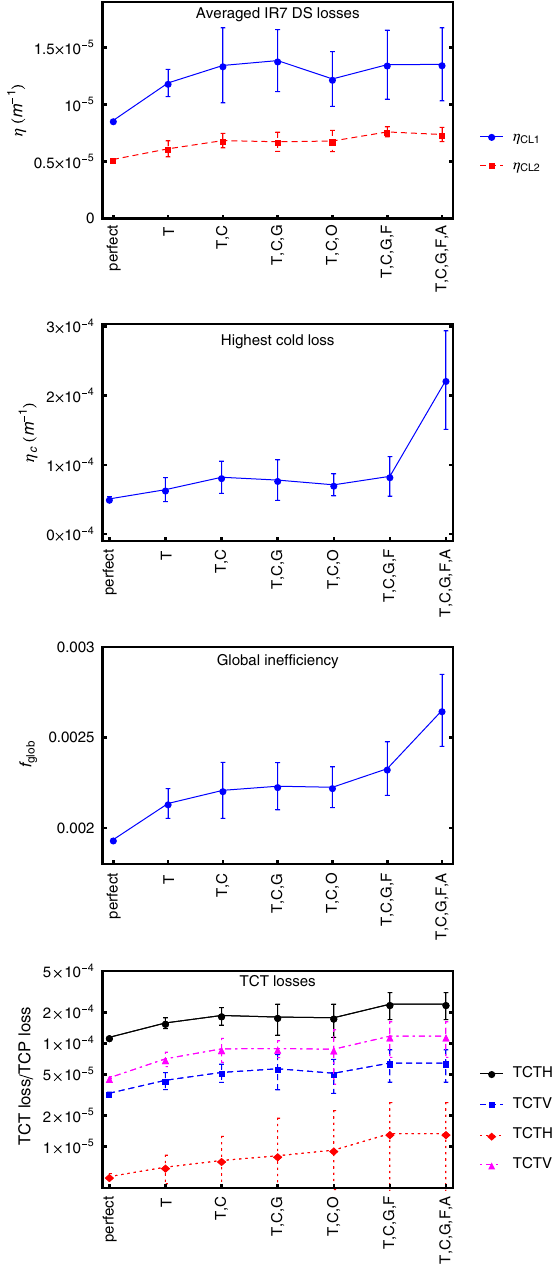
FIG. 12. The influence, as simulated with SixTrack, of different machine imperfections (T designates tilt error; C designates center error; G designates gap error; O designates optics errors introduced in the lattice in MAD-X; F designates jaw flatness error; A designates aperture misalignments) on different